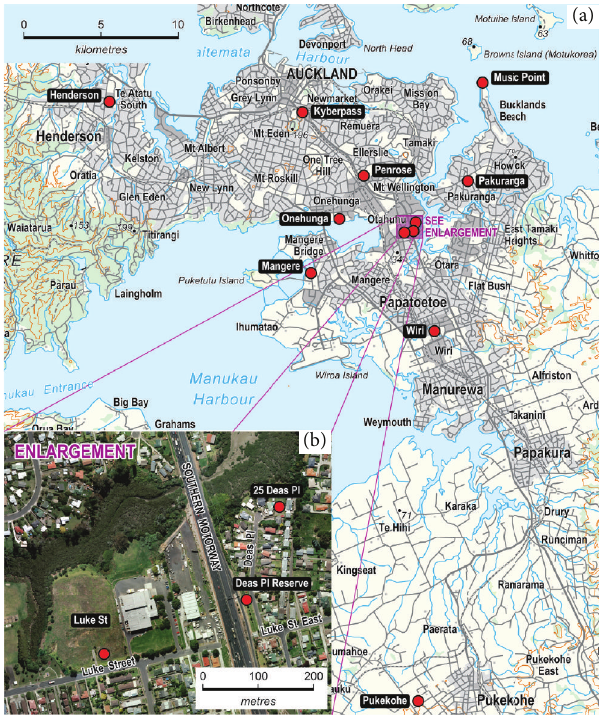
Figure 1: Map of monitoring locations used in this study. (a) Map showing twelve wind sites; (b) enlarged view of the three air pollution measurement sites with on-site anemometers for wind